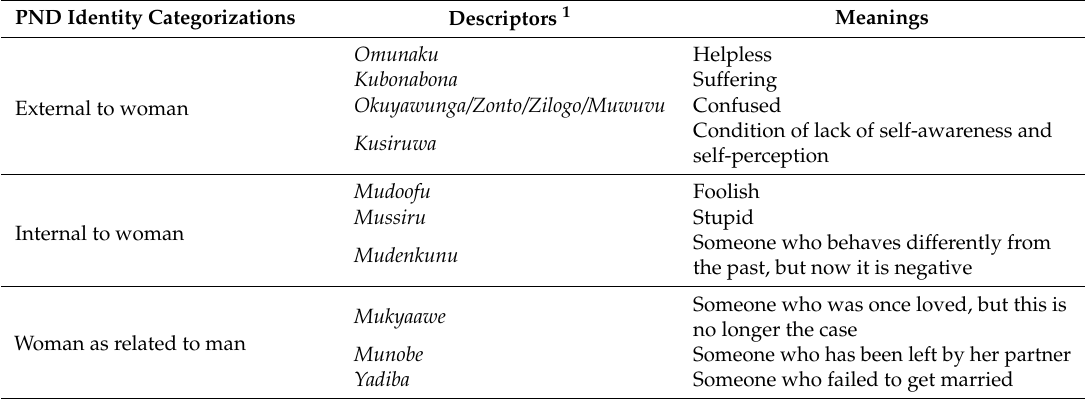
Table 3. Perceived identity categorizations of PND highlighting a woman’s